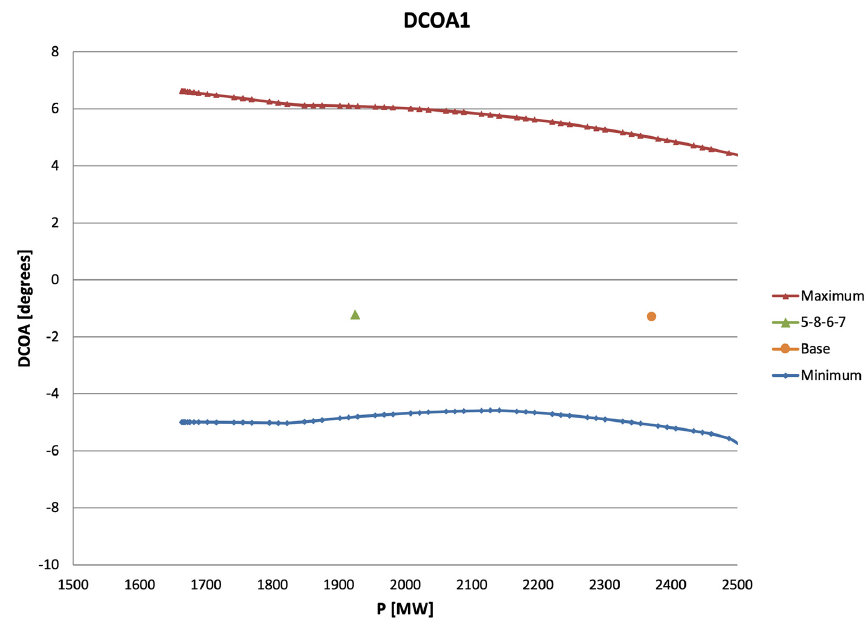
Figure 15. Angular threshold characterization for contingencies N-1 in operational area 1 (outages of lines 5–8 and 6–7).